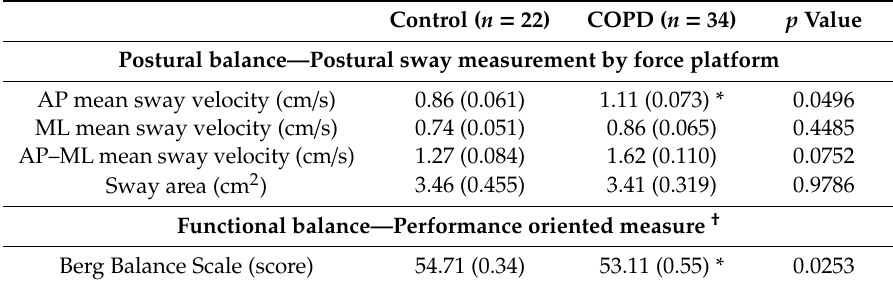
Table 2. Balance function by postural sway and the Berg Balance Scale of the COPD and control